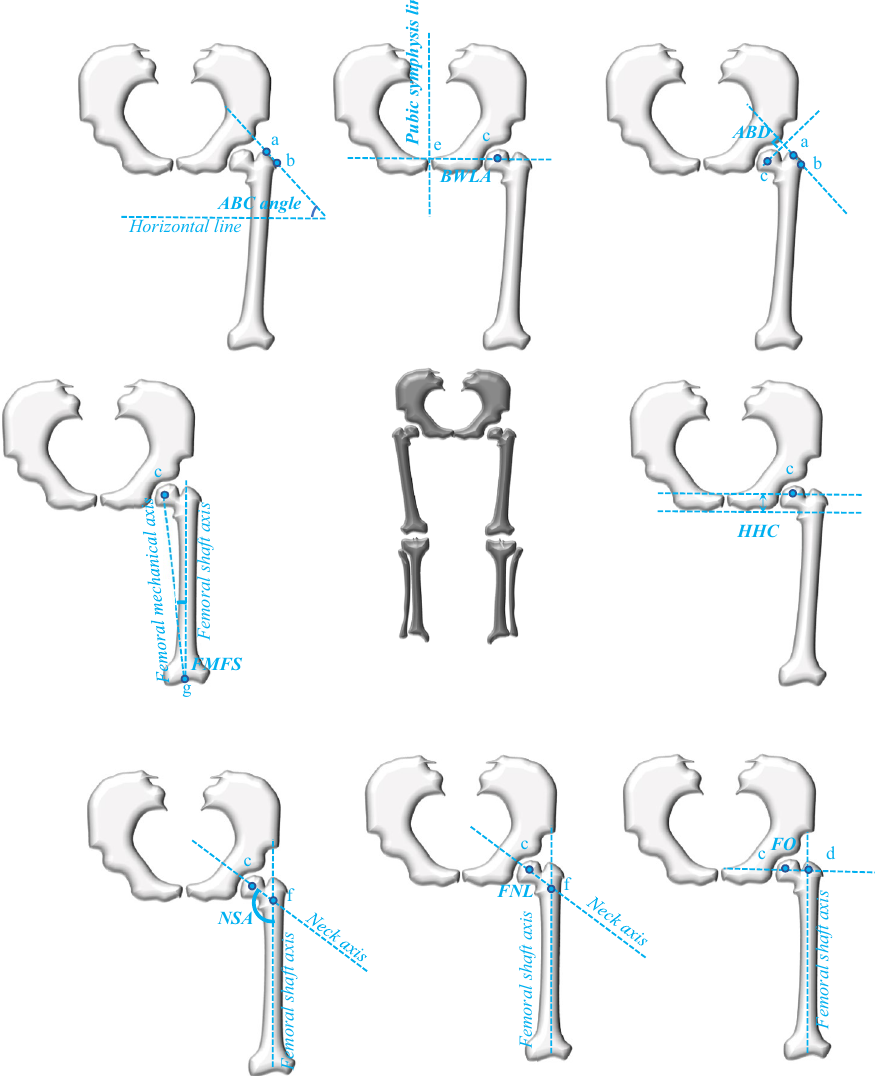
Figure 1. The hip geometry was measured on the anteroposterior view. ABC Abductor angle, BWLA body weight lever arm, ABD abductor lever arm, HHC height of the hip center, FO femoral offset, FNL Femoral neck length, NSA neck-shaft angle, FMFS angle between the femoral mechanical axis and the femoral shaft